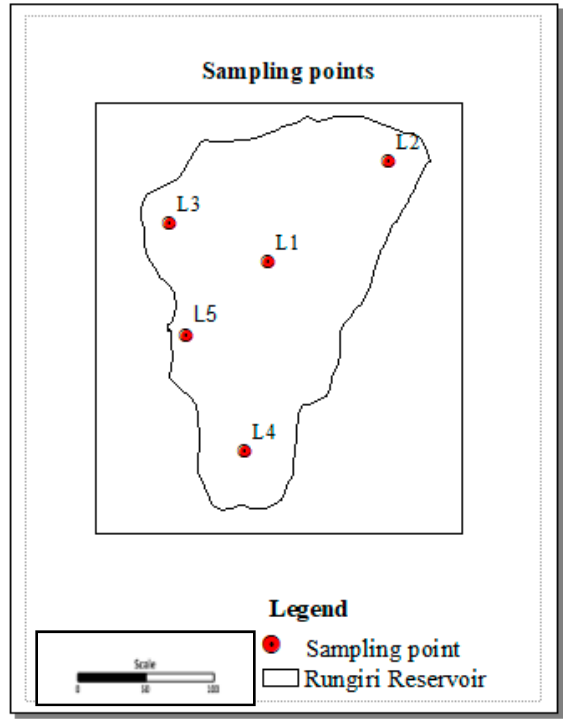
Figure 3. Rungiri quarry reservoir sampling points.